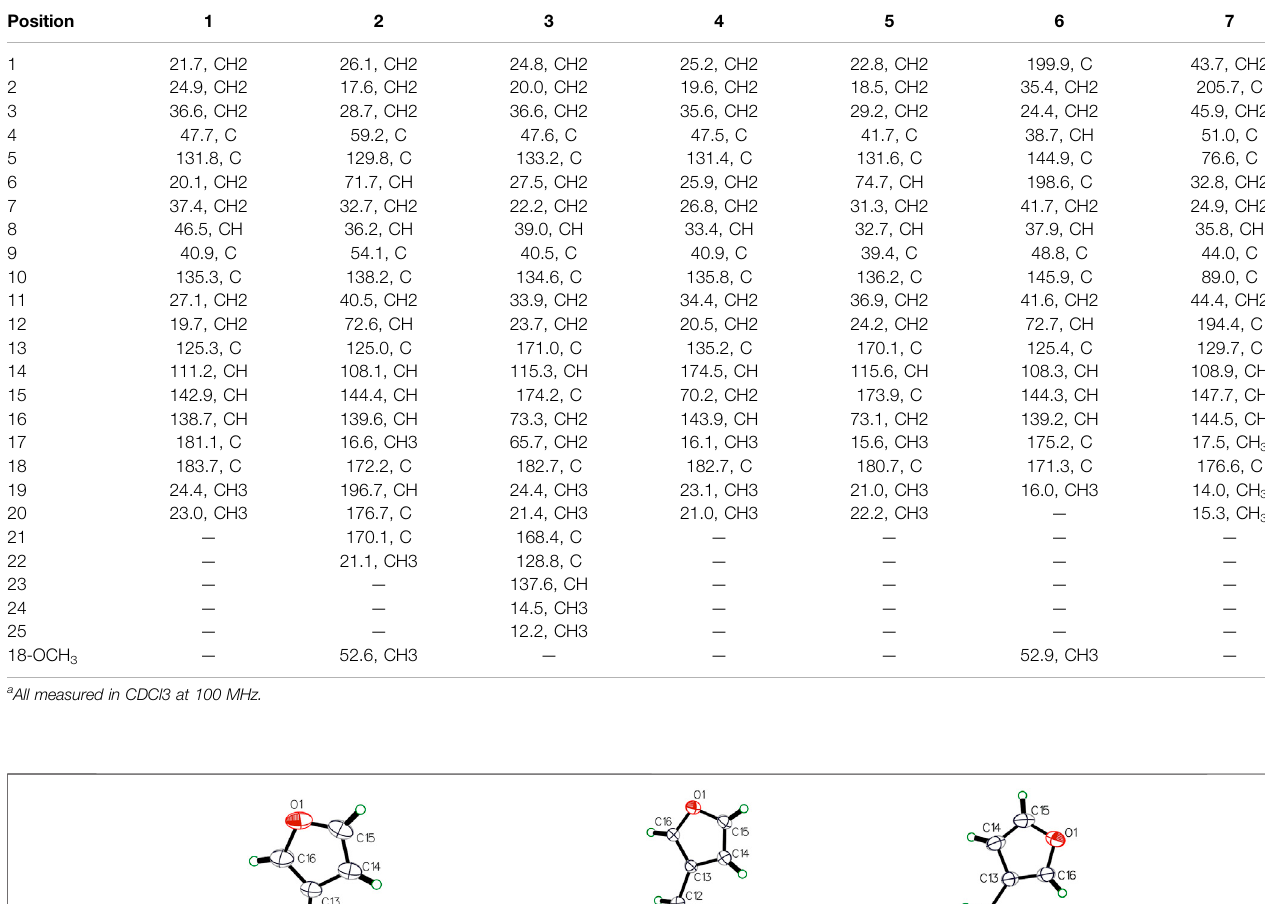
TABLE 2 | 13 C NMR data of 1 – 7 ( δ in ppm) a .